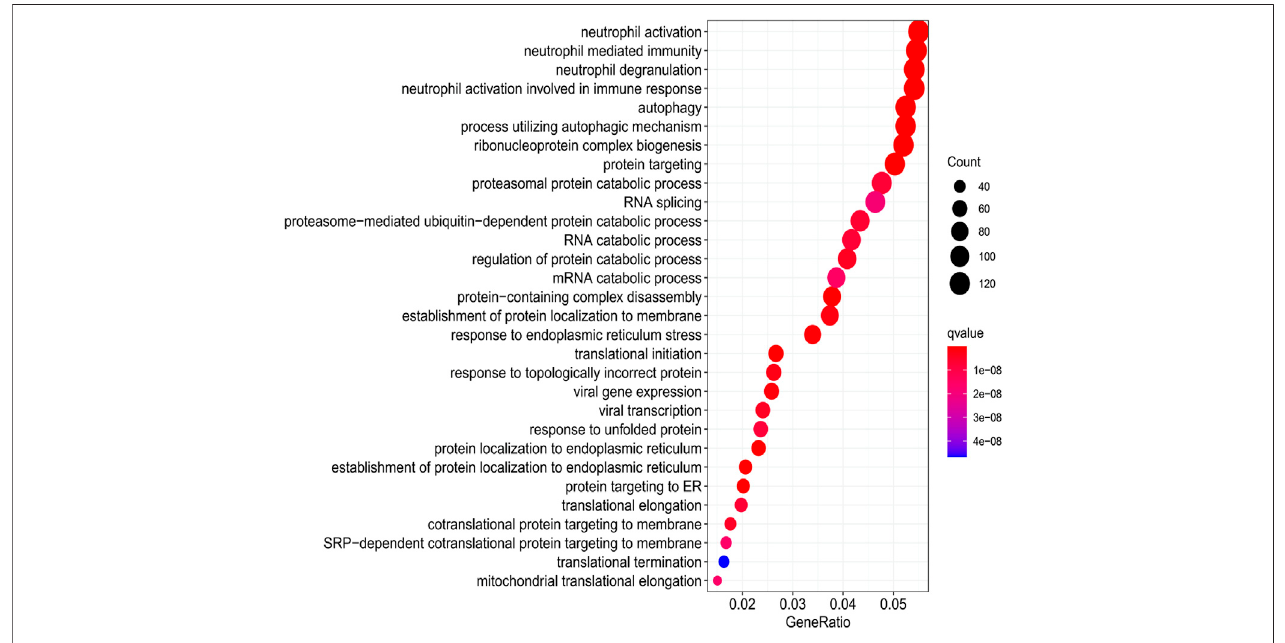
FIGURE 5 | KEGG analysis exhibits the enrichment of ATP2A1 in colorectal cancer.